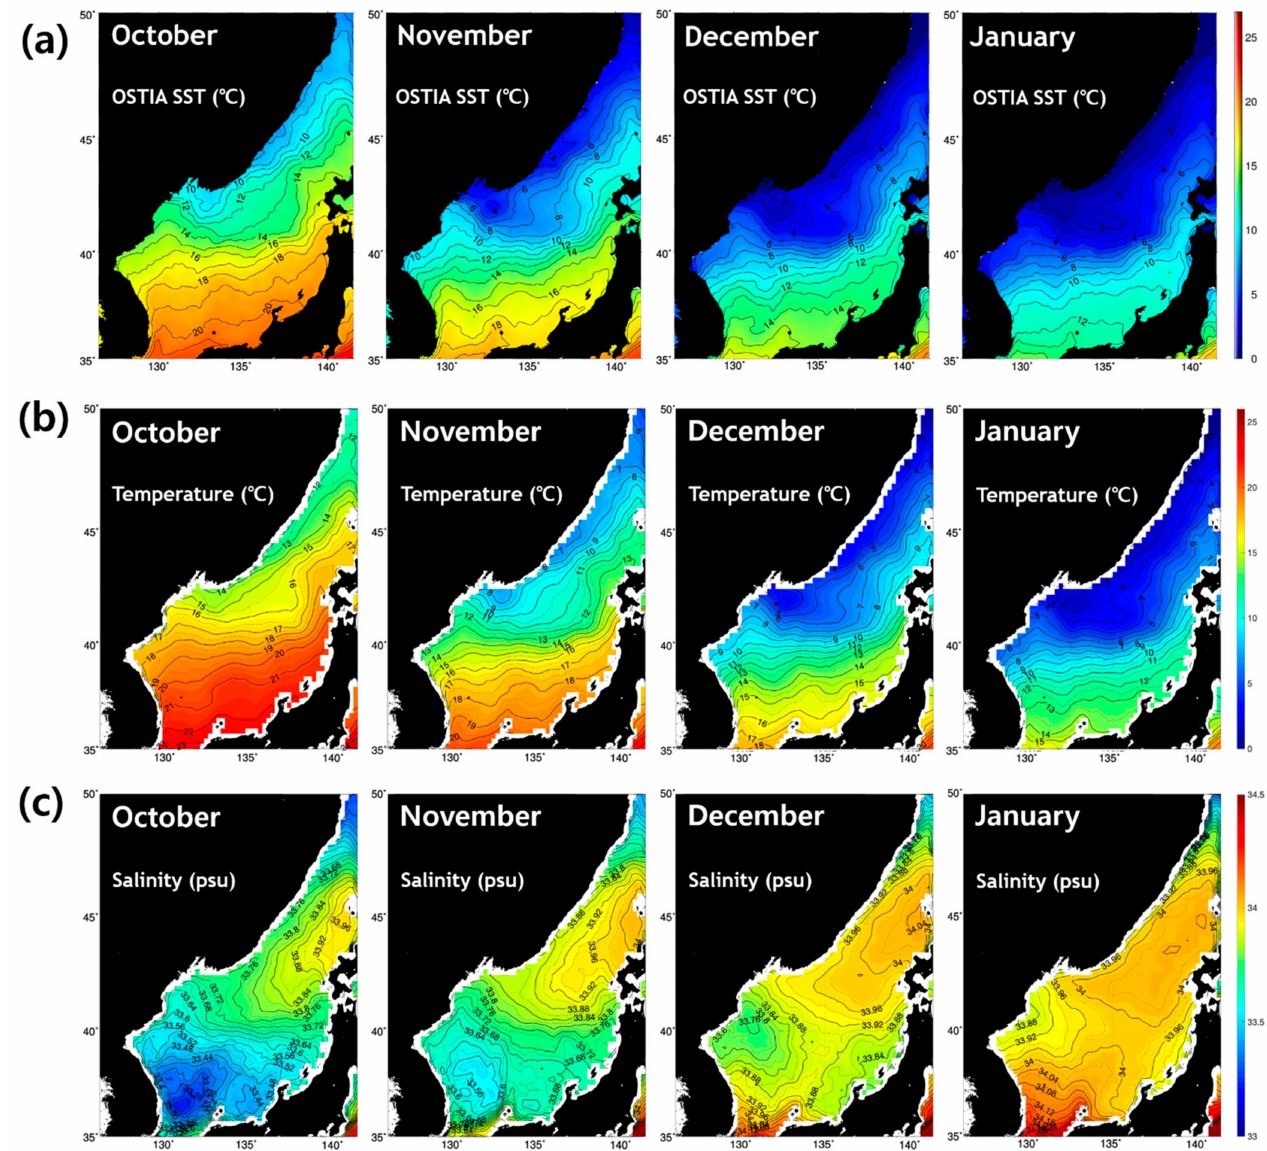
Figure 3. Horizontal distribution of climatological monthly mean ( a ) sea surface temperature (SST) from Operational Sea Surface Temperature and Sea Ice Analysis (OSTIA), ( b ) temperature, and ( c ) salinity at 20 m depth from HYbrid Coordinate Ocean Model (HYCOM) reanalysis in October–January averaged from 1993 through